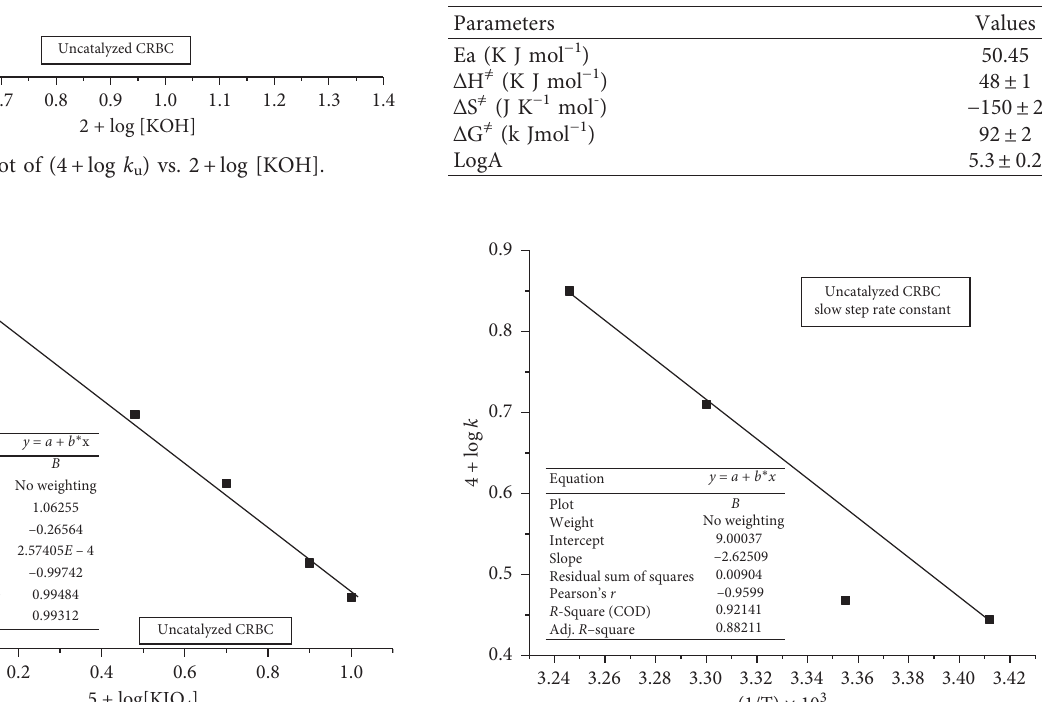
Figure 11: Plot of (4+log k ) vs. (1/ T ) × 10 3